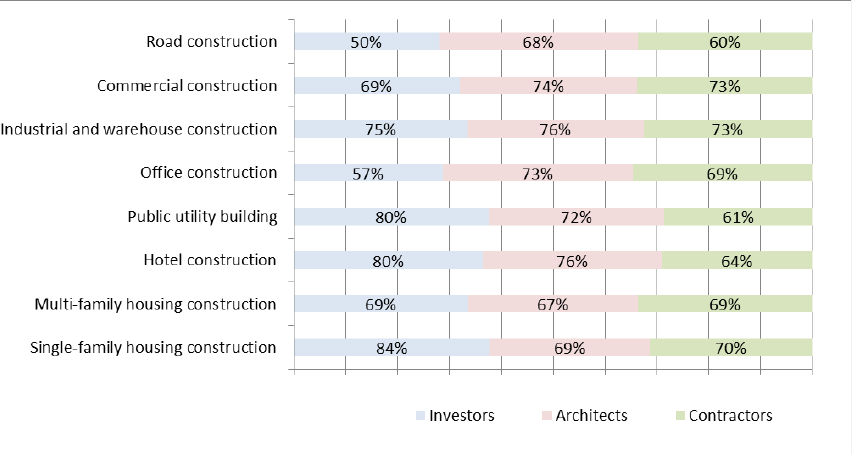
Figure 1. The use of prefabricated concrete elements during the implementation of the investment.